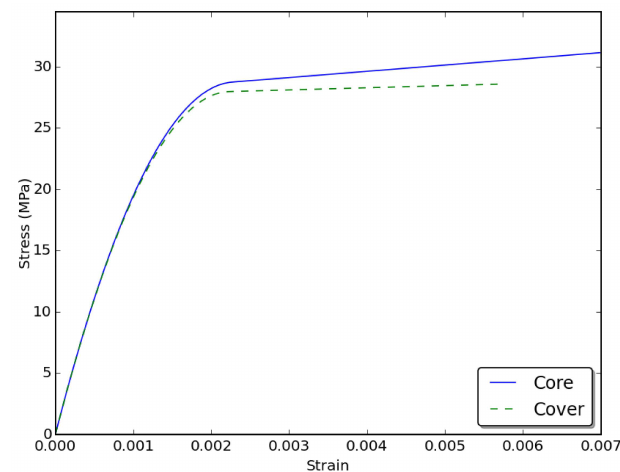
Figure 18. Stress-strain curve for Sample 1, s = 50.8